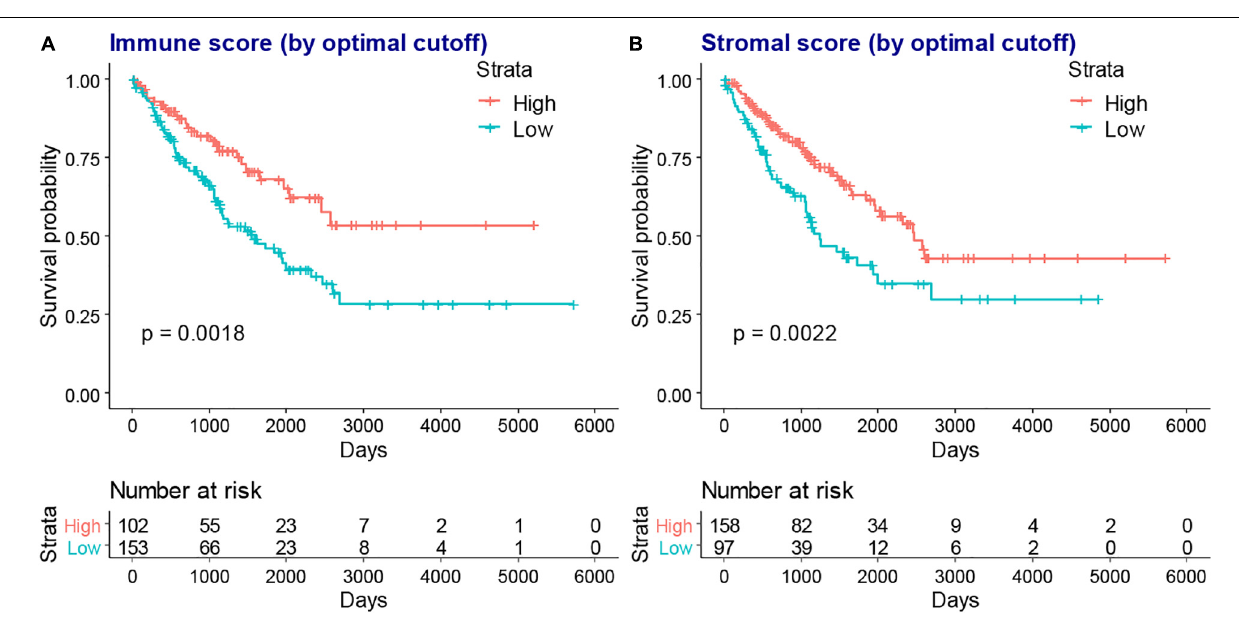
Frontiers in Genetics |